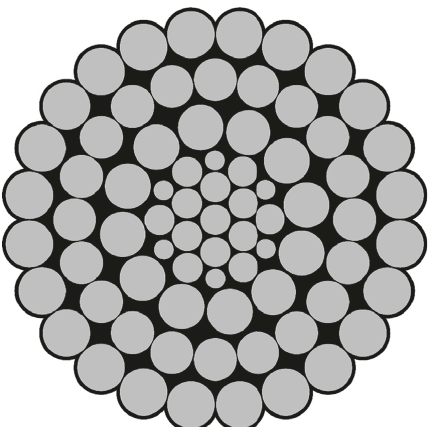
Figure 10: Cross section of the individual suspender